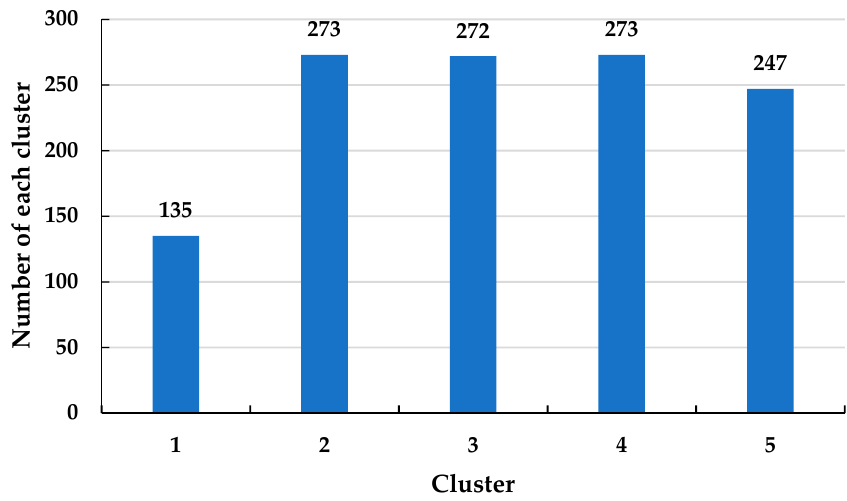
Figure 20. The number of the sheath current samples in each cluster.